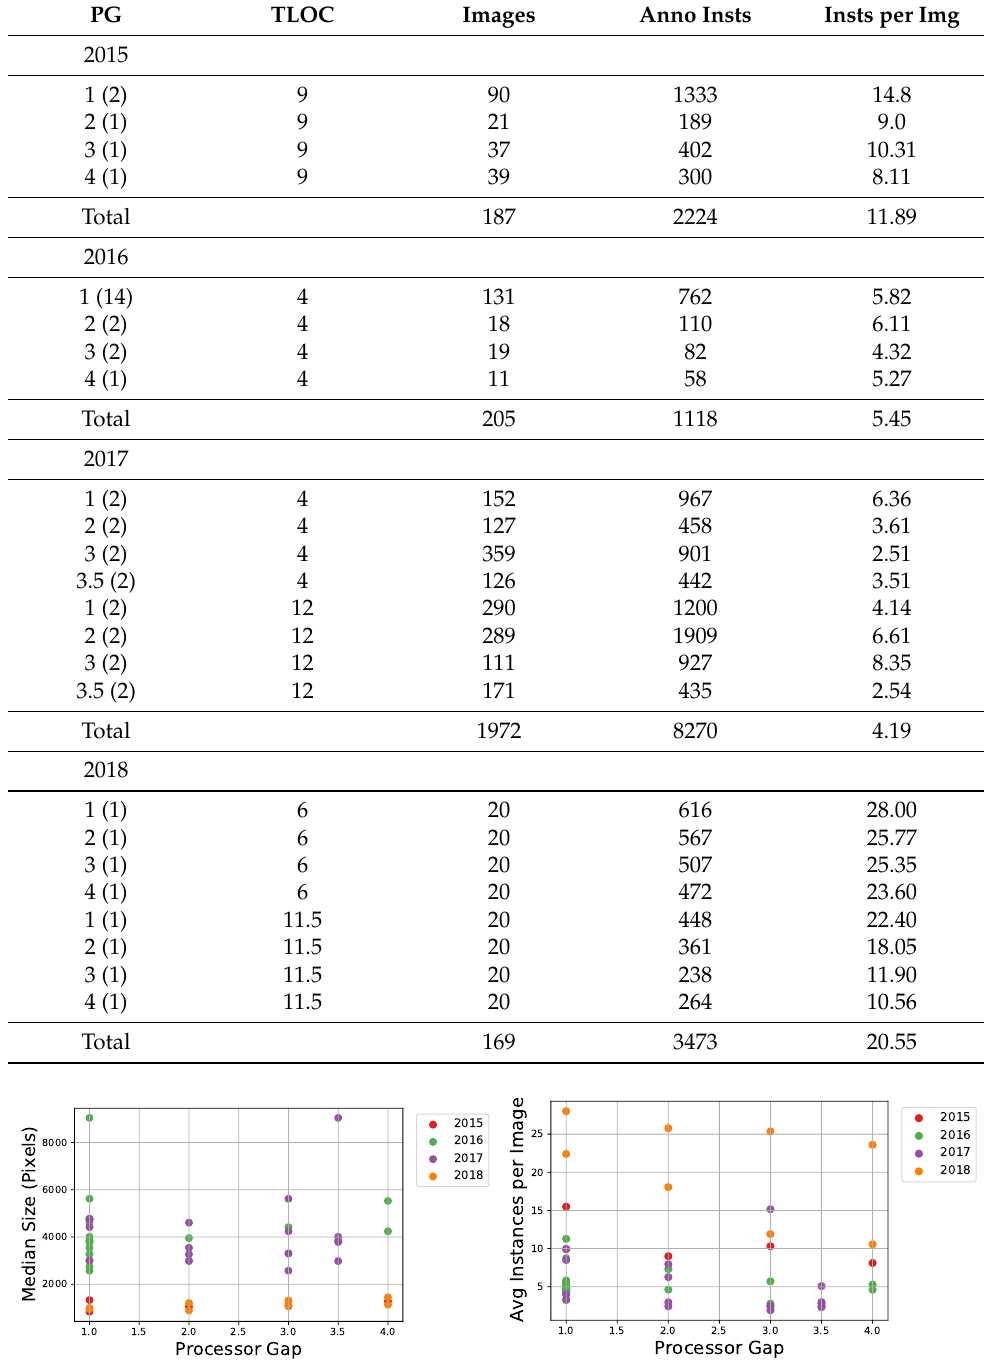
Table 1. Annotation statistics for the images captured over four different harvest seasons.